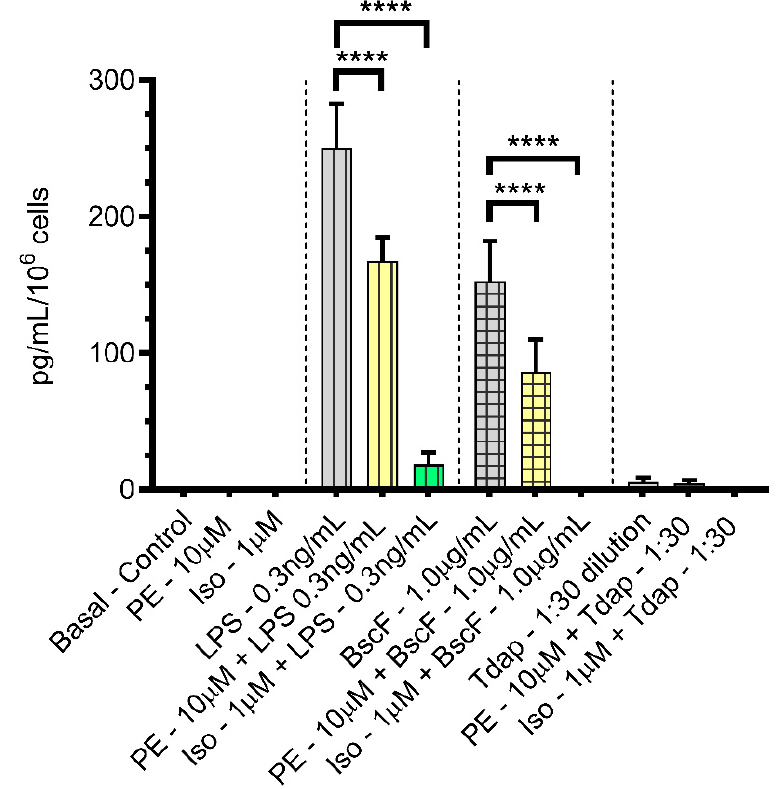
Figure 2. Both PE and ISO reduced the expression of chemokine CXCL10 upregulated by LPS or B. pertussis antigens, BscF and Tdap, in THP-1 cells. THP-1 cells treated with PBS, PE alone (10.0 µM), and ISO alone (1.0 µM) as control treatments, LPS alone (0.3 ng/mL), BscF alone (1.0 µg/mL), and